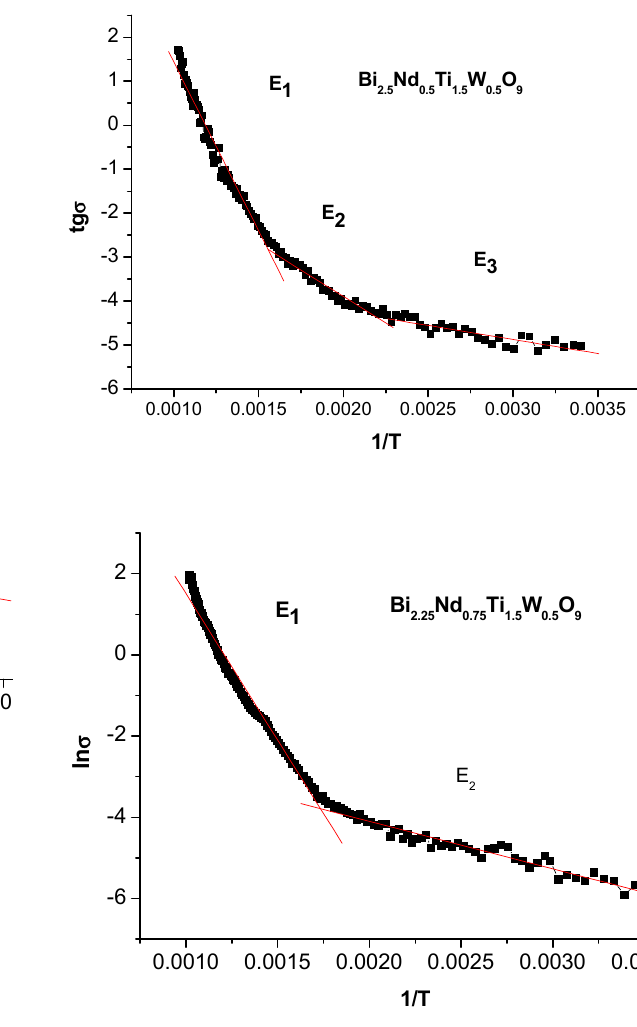
Figure 4. Dependence of ln σ on 1/ T for the Bi 3 − x Nd x Ti 1.5 W 0.5 O 9 (x = 0.25, 0.5, 0.75) sample.